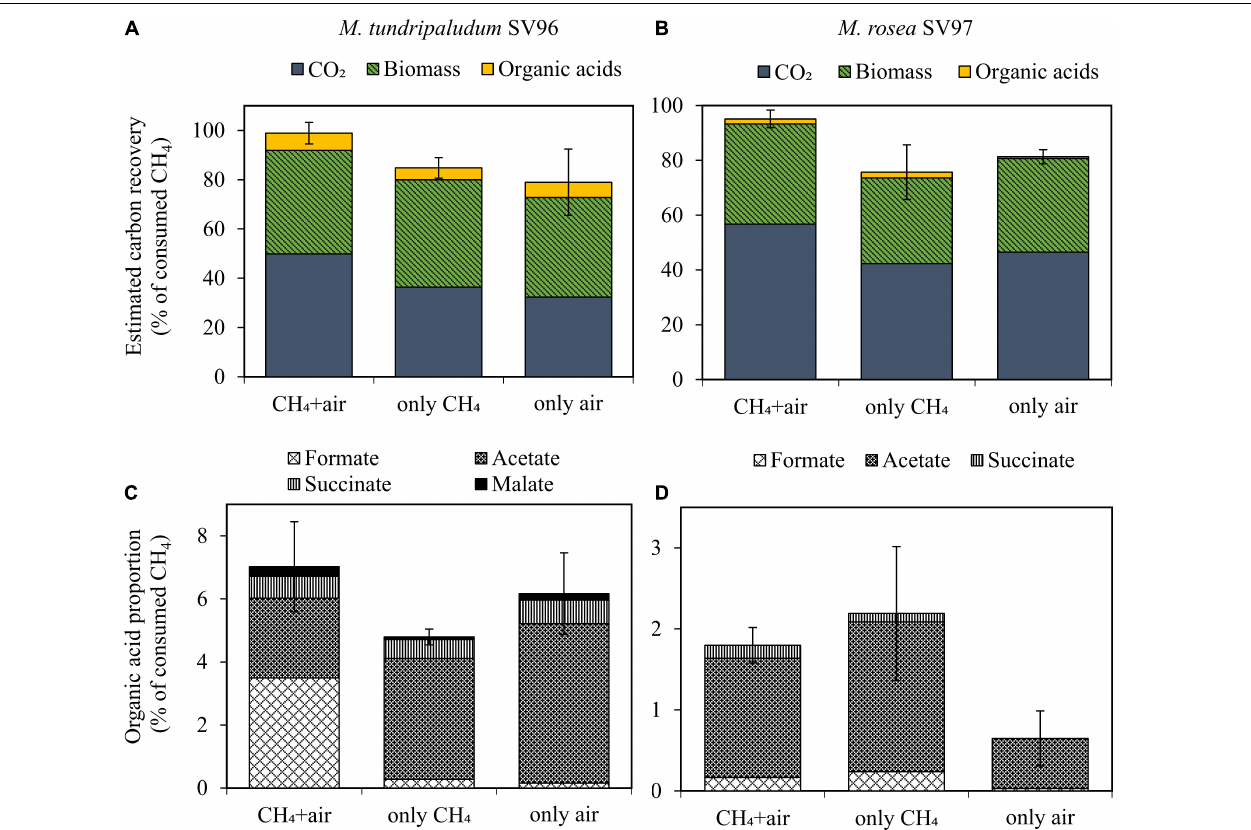
FIGURE 5 | Carbon mass balance applied to CH 4 oxidation to CO 2 , biomass, and organic acids (A,B) and distribution of each organic acid compound (C,D) of M. tundripaludum SV96 (left) and M. rosea SV97 (right) in three different gas supplementation tests for the 14-day incubation. Error bars indicate the standard deviation of sum of total yields in